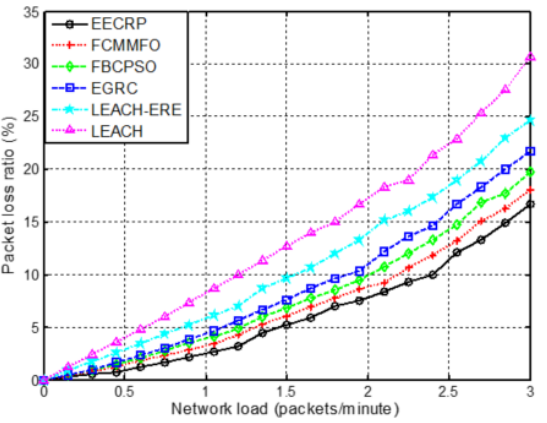
Figure 13. The packet loss ratio versus network load.